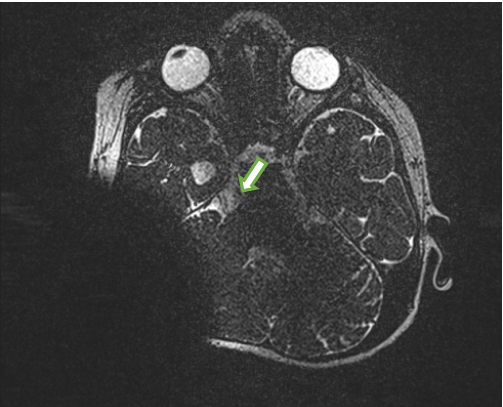
Figure 3. MRI of the patient. The arrow shows hypoplastic trigeminal nerve on the right side (MRI defect due to the cochlear implant).